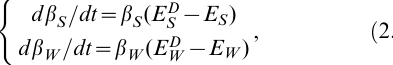
) are the stable W